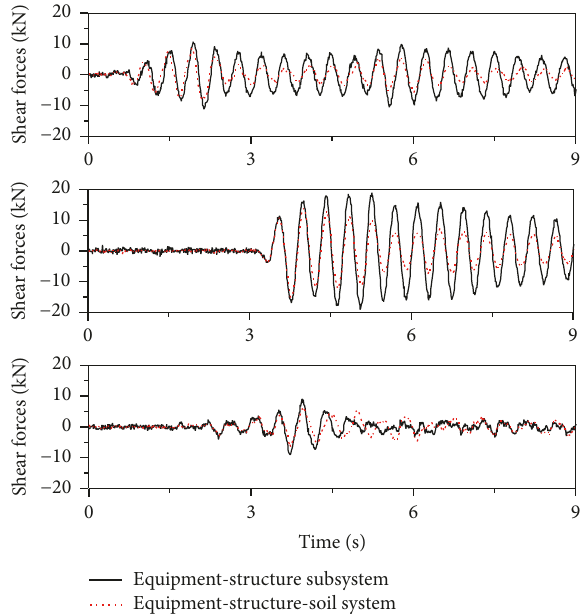
Figure 12: Shear force responses of different systems during the minor earthquake.